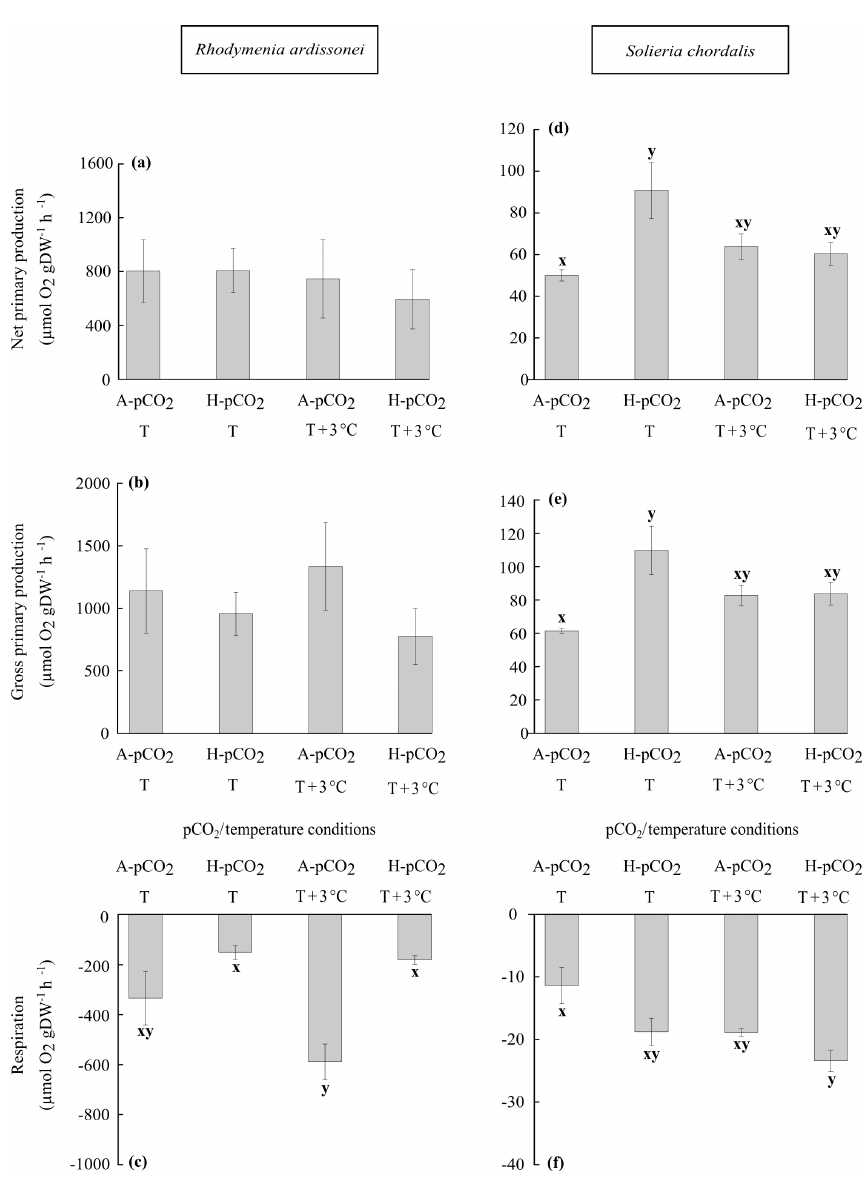
Figure 3. Summer net and gross primary production and respiration rates (mean ± SE, n = 5) of the two main epiphytic fleshy algae Rhody- menia ardissonei (a–c) and Solieria chordalis (d–f) , in the different p CO 2 (A- p CO 2 is ambient p CO 2 ; H- p CO 2 is high- p CO 2 ) and temper- ature ( T is ambient temperature; T + 3 ◦ C is high temperature) treatments. Letters indicate significant differences between the four treatments in summer (x, y) conditions (Tukey HSD test). Tukey tests were performed when a significant effect of temperature or p CO 2 was